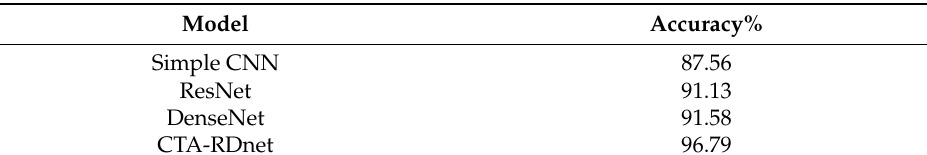
Table 4. Experimental results of different models.